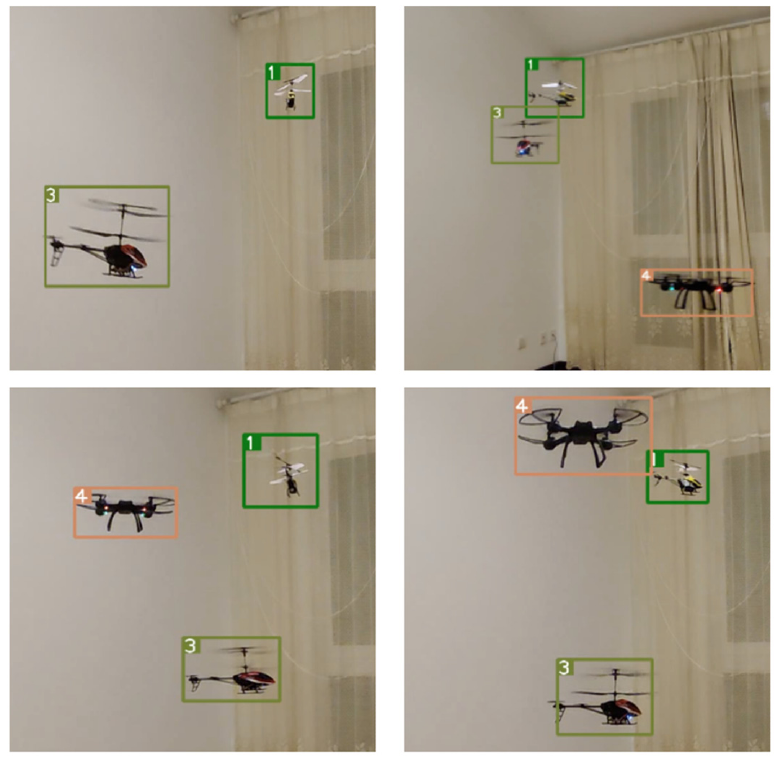
Figure 14. Setup of UAV tracking dataset.